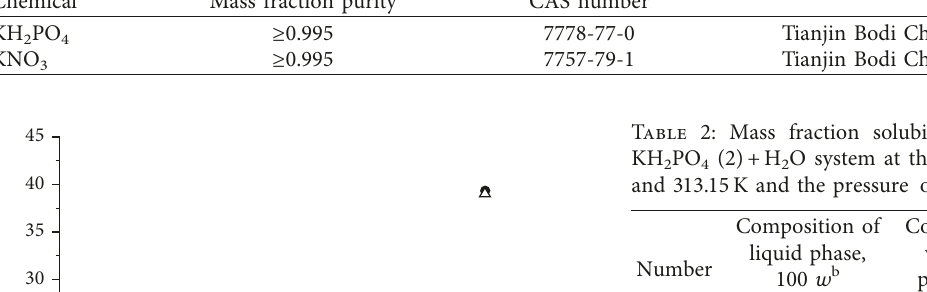
Table 1: Purities and suppliers of chemicals.